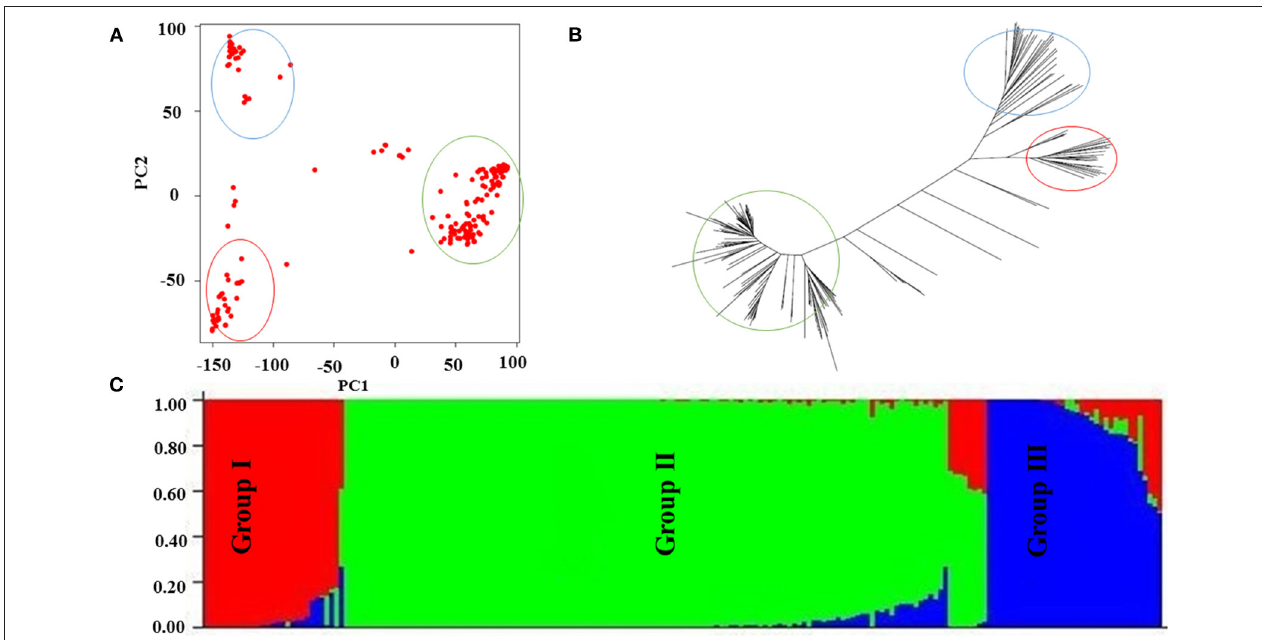
FIGURE 3 | Population structure of current association panel. (A) Population structure of rice germplasm collection as reflected by principal components (PCs). The principal components analysis (PCA) plot of the first two components divided the rice panel into three main groups, (B) the dendrogram of neighbor-joining clustering, constructed using 36,901 SNPs, and the results show that genotypes are divided into three main groups, and (C) Bayesian clustering of 197 rice accessions using STRUCTURE; again, the results show that genotypes are divided into three main groups.